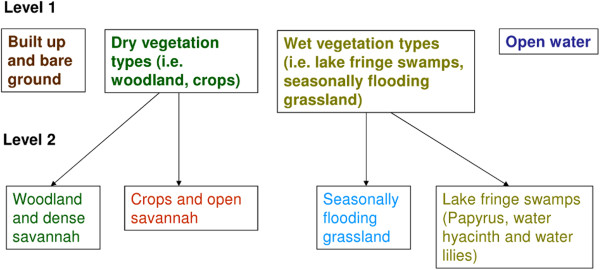
Land cover class hierarchy showing super-classes (level 1) and sub-classes (level 2).